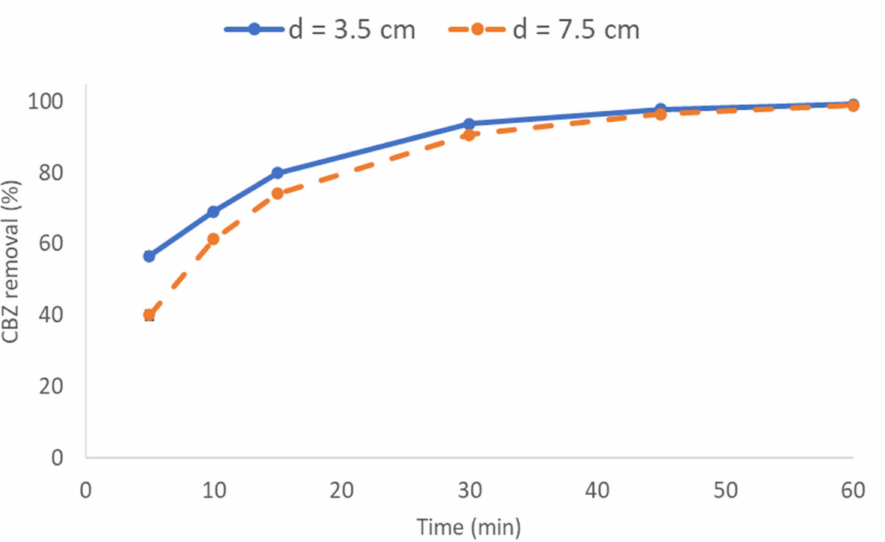
Figure 10. Effect of interelectrode distance on the CBZ removal from aqueous solutions (operational conditions: j = 6.67 mA/cm2; NaCl = 0.1 M; CBZi = 10 mg/L; pH = 7; reaction time = 60 min;